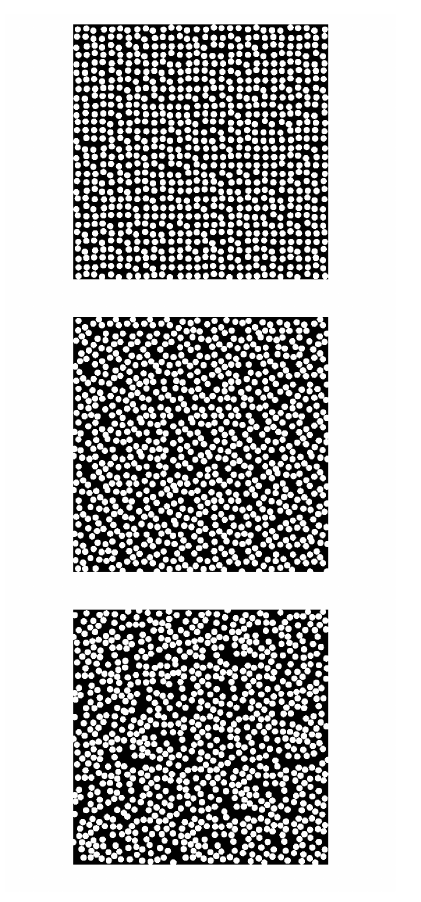
Figure 1. Examples of tilings with: 1 inclusion/tile (30 × 30 tiles), 4 inclusions/tile (15 × 15 tiles), 36 inclu- sions/tile (5 × 5 tiles); Wang tiling set of 8 tiles over 4